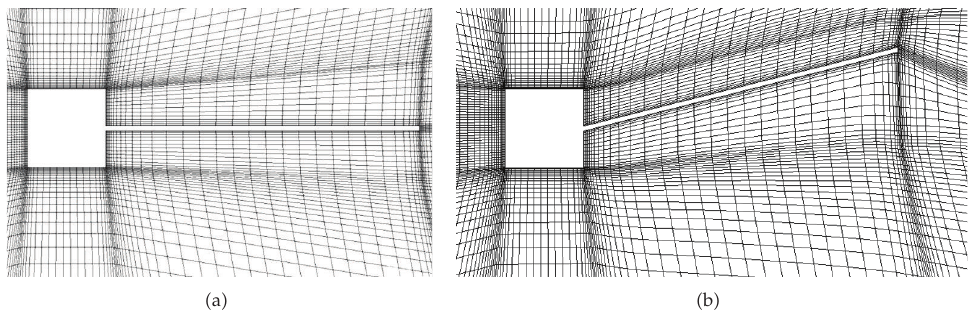
Figure 2: Nondeformed mesh compared to a deformed mesh.